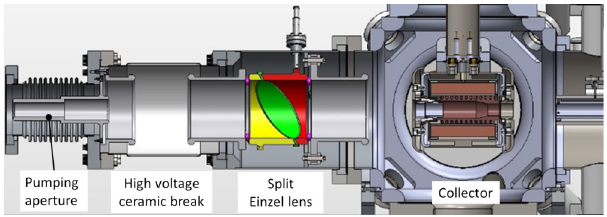
FIG. 3. Rendering cut of a model of the high-acceptance “ split ” Einzel lens recently installed near the acceleration gap to reduce emittance growth and allow for horizontal and vertical beam steering during injection and